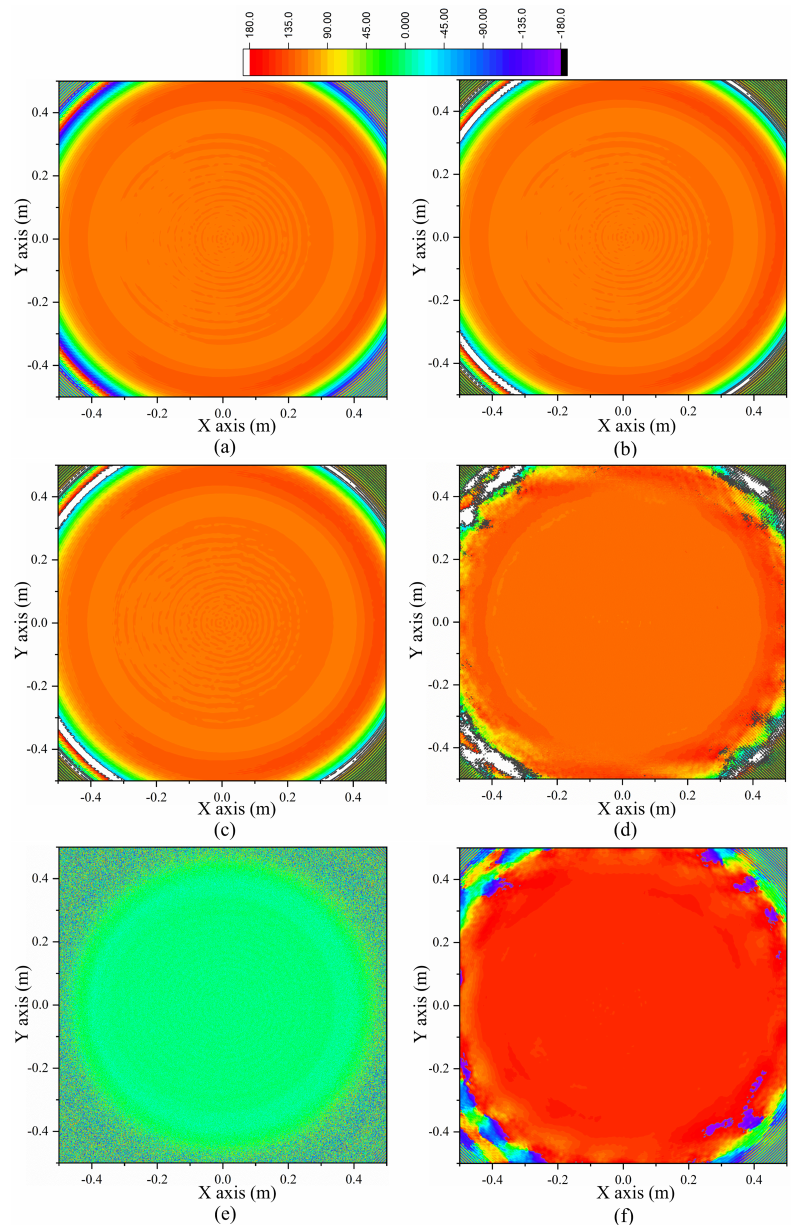
Figure 10. The 2-D target phase distribution ( a ) at f = 220 GHz as well as the 2-D phase distribution recovered by the proposed SPP GS/HIO-HIO algorithm ( b ), GS/HIO algorithm ( c ), hybrid GS/HIO algorithm ( d ), HIO algorithm ( e ), and GS algorithm ( f